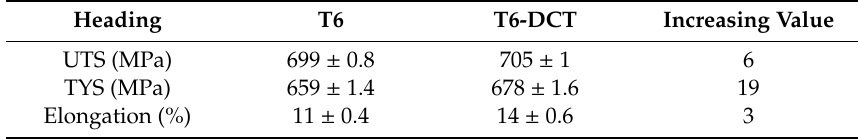
Table 4. Tensile properties of indirectly extruded 7A99 aluminum alloy plates subjected to T6 and T6-DCT